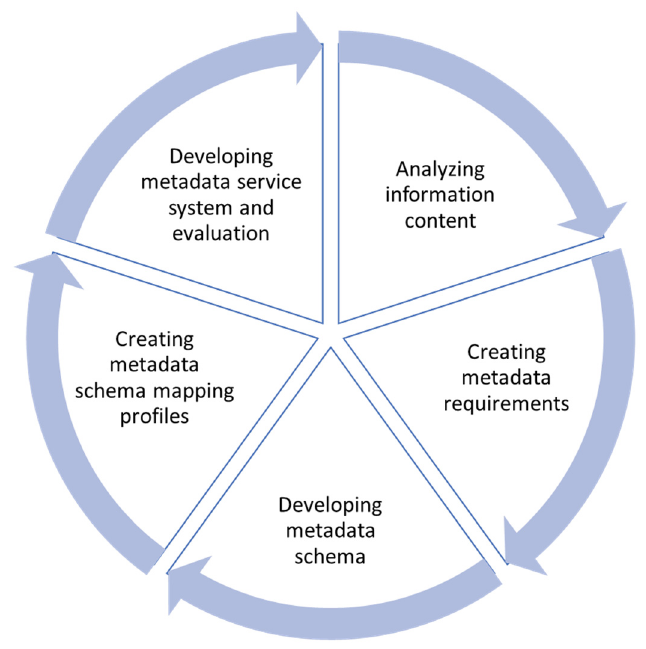
Figure 1. Metadata integration framework defined based on the Metadata Lifecycle Model.